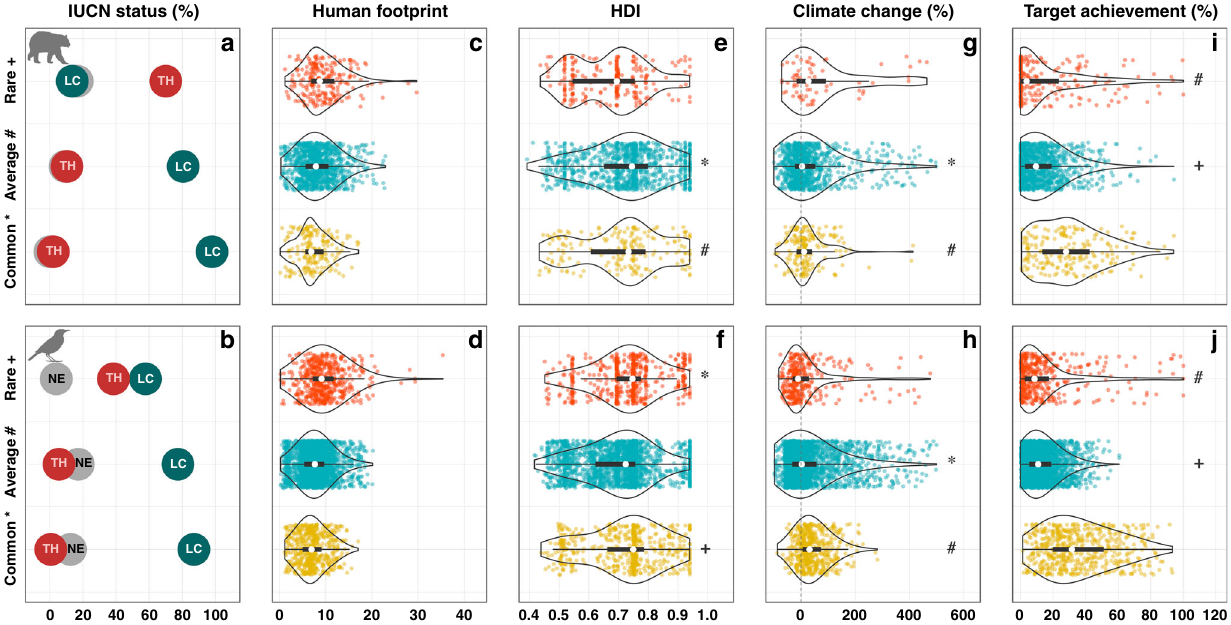
Fig. 5 Vulnerability to current and future threats of ecologically rare, average, and common mammal and bird species. a , b Percentage of species per IUCN status according to criteria by the IUCN Red List, Threatened (TH red: Vulnerable, Endangered, Critically Endangered), Least concern (LC green: Least Concern and Near Threatened) and Not Evaluated (NE gray: Not Evaluated or inadequate information). c , d Human Footprint that measure the cumulative impact of direct human pressures; e , f Human development index (HDI) which is a statistic composite index of life expectancy, education, and per capita income indicators; g , h Change in distribution range based on climate change projections (scenario RCP 8.5, Horizon 2041 – 2060, see Supplementary Fig. 10 for Horizon 2061 – 2080) and i , j Target achievement (extent to which species are represented within PAs regarding their restrictiveness). Symbol indicate signi fi cant similar distribution between groups ( P < 0.05 , See Supplementary Table 3 for all p value) via one-way ANOVA and Tukey ’ s post-hoc tests. Icons were generated using R ( rphylopic package) and are under the Public Domain Dedication 1.0